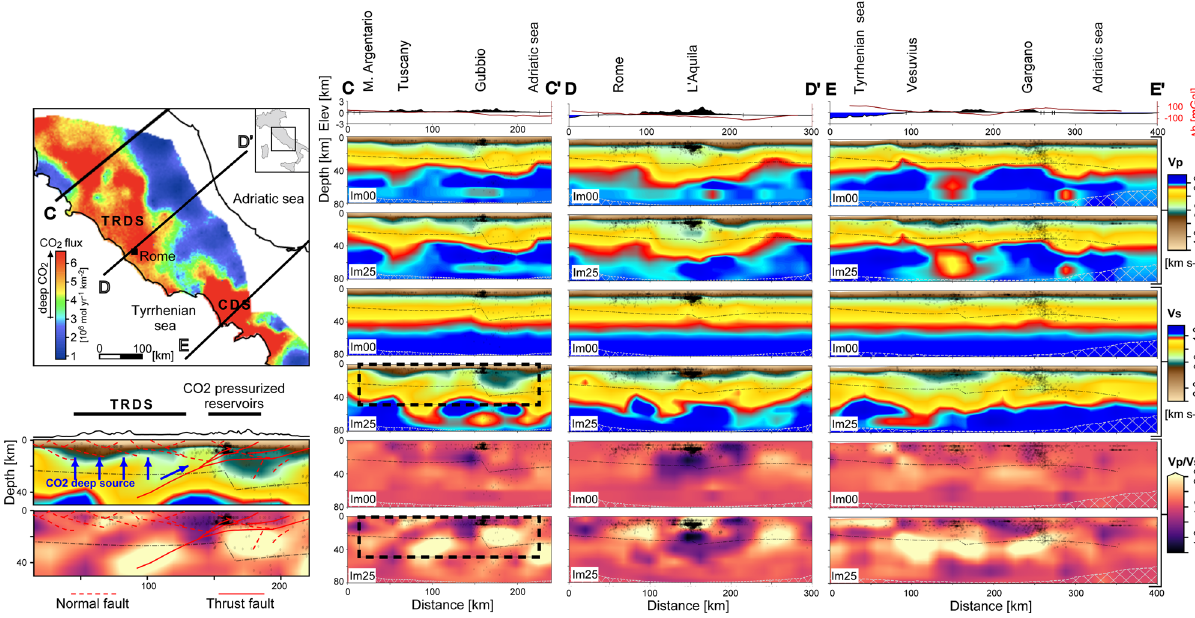
Fig. 2 Detailed vertical cross-sections of models Im00 and Im25 for sections CC ’ , DD ’ , EE ’ , and comparison with CO 2 degassing areas. For each section we show surface topography and Bouguer anomalies (top), and V p , V s , and the V p / V s ratio for models Im00 and Im25 . Dotted black lines in each section represent the Moho 29 . White dashed areas are not well-resolved in Im25 model. Black dots represent relocated seismicity from the Italian Bulletin of INGV 85 . The map (modi fi ed after 58 ) represents the degassing of CO 2 from deep sources; TRDS is the Tuscan-Roman degassing structure and CDS is the Campanian degassing structure. The sections below show a close-up of section CC' for V s and V p / V s in Im25 model within the boxes highlighted in the sections CC' (black dashed contours). The superimposed traces are structural features 58